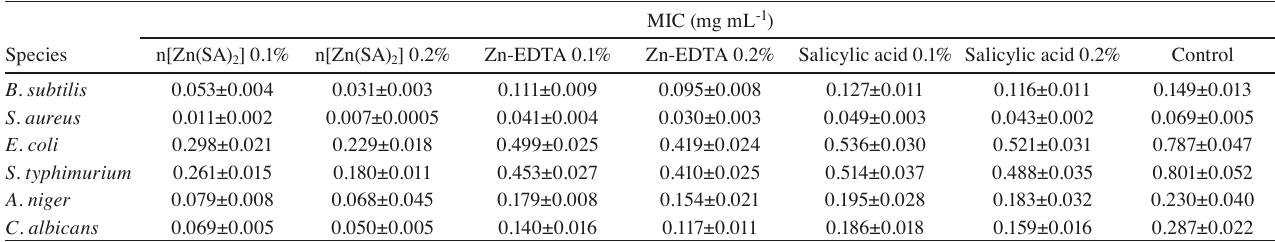
Tab. 4: Antimicrobial activity of sweet basil’s essential oils affected by different zinc and salicylic acid